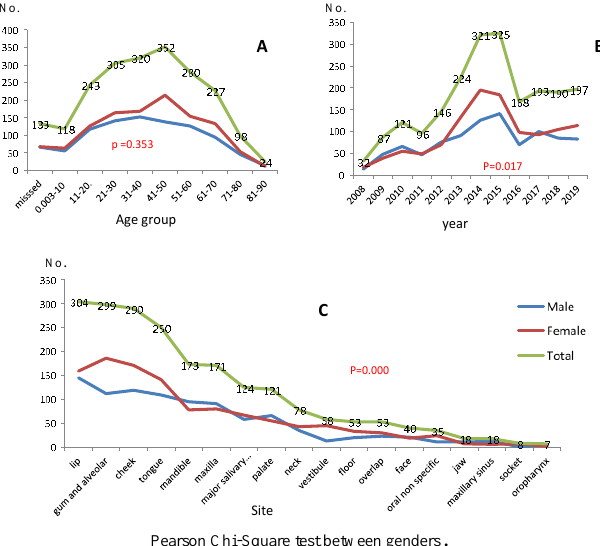
Figure 1 : Frequency distribution of 2100 oro-maxillofacial reported surgical biopsies in Sulaimani city according to the age group (A), years of registration (B), and anatomical site (C) Neoplastic lesions were reported in 642 (30.6%) cases, and the non-neoplastic diagnosis was registered in 1458 (69.4%) cases. The non-neoplastic biopsies were more frequently seen in females (n=834, 57.2%) than males (n= 624, 42.8%). While the neoplasms were nearly equally seen in male (n=325, 50.6%) and female (n=317, 49.4%) patients. There were significant differences in age and site distribution between neoplastic and non-neoplastic lesions.